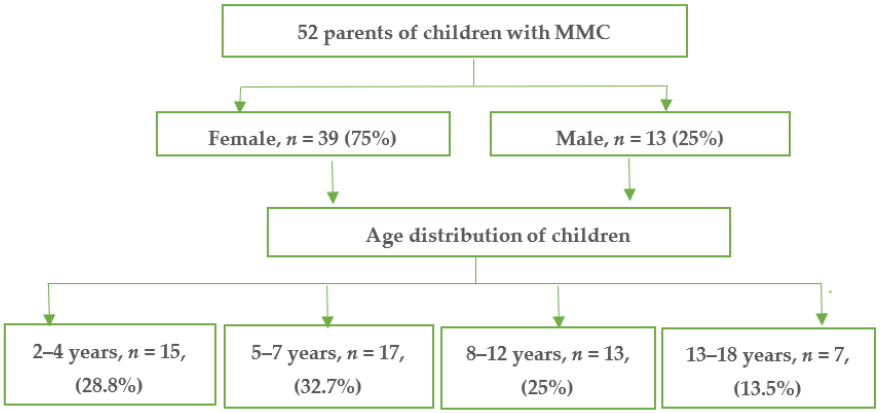
Figure 1. Flowchart of study population.